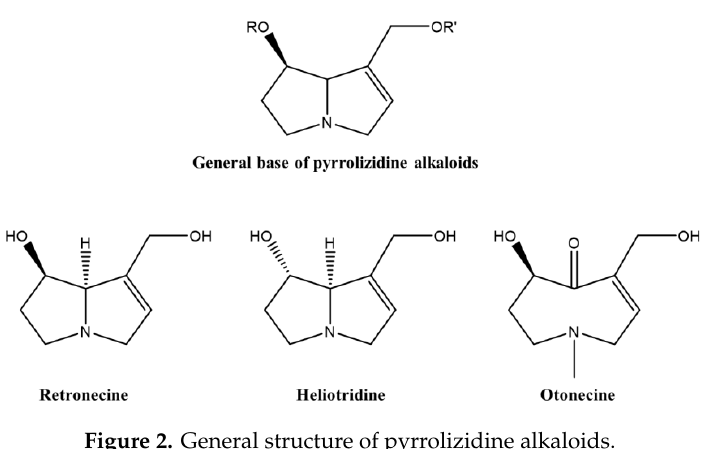
Figure 3. Phyto-hepatotoxins induce liver injury through oxidative stress. The mechanic pathway is derived from a published report by Xu et al. [109].